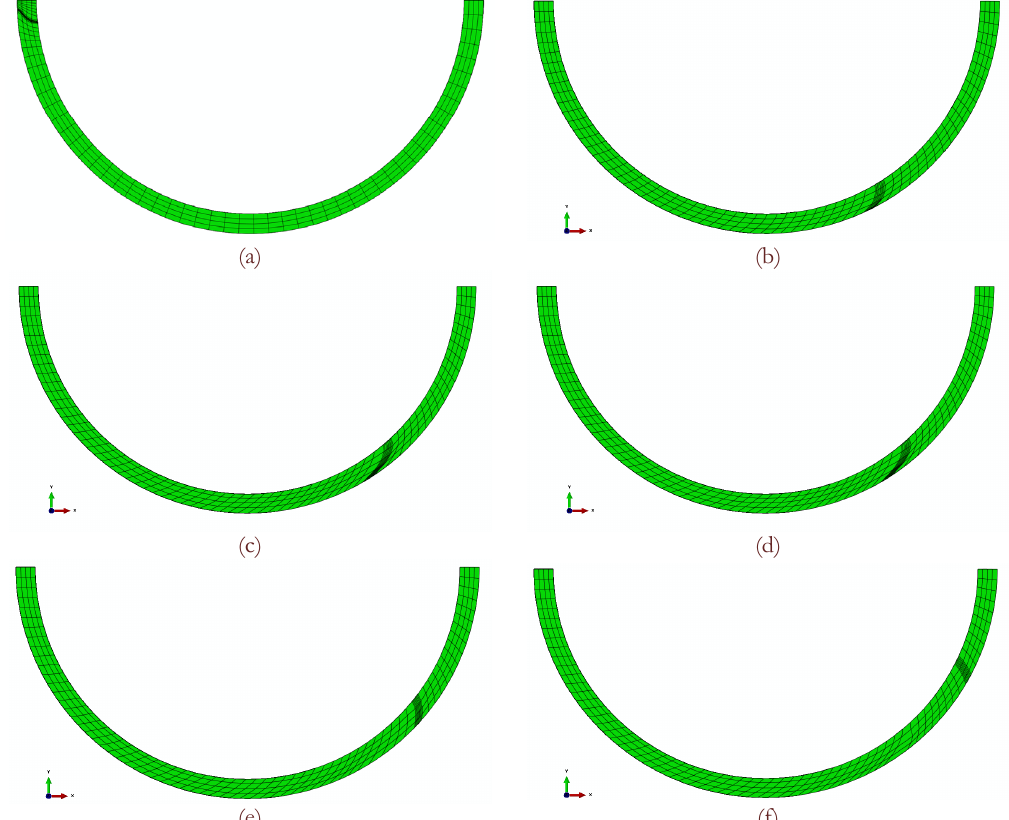
Figure 20: Multi-step procedure at Stage 2: (a) initial through-the-thickness crack; (b) crack configuration at end of Step 1 (TW 1); (c) crack configuration at end of Step 2 (TW 2); (d) crack configuration Step 3 (TW 3); (e) crack configuration Step 4 (TW 4); (f) crack configuration at Step 5 (TW 5).